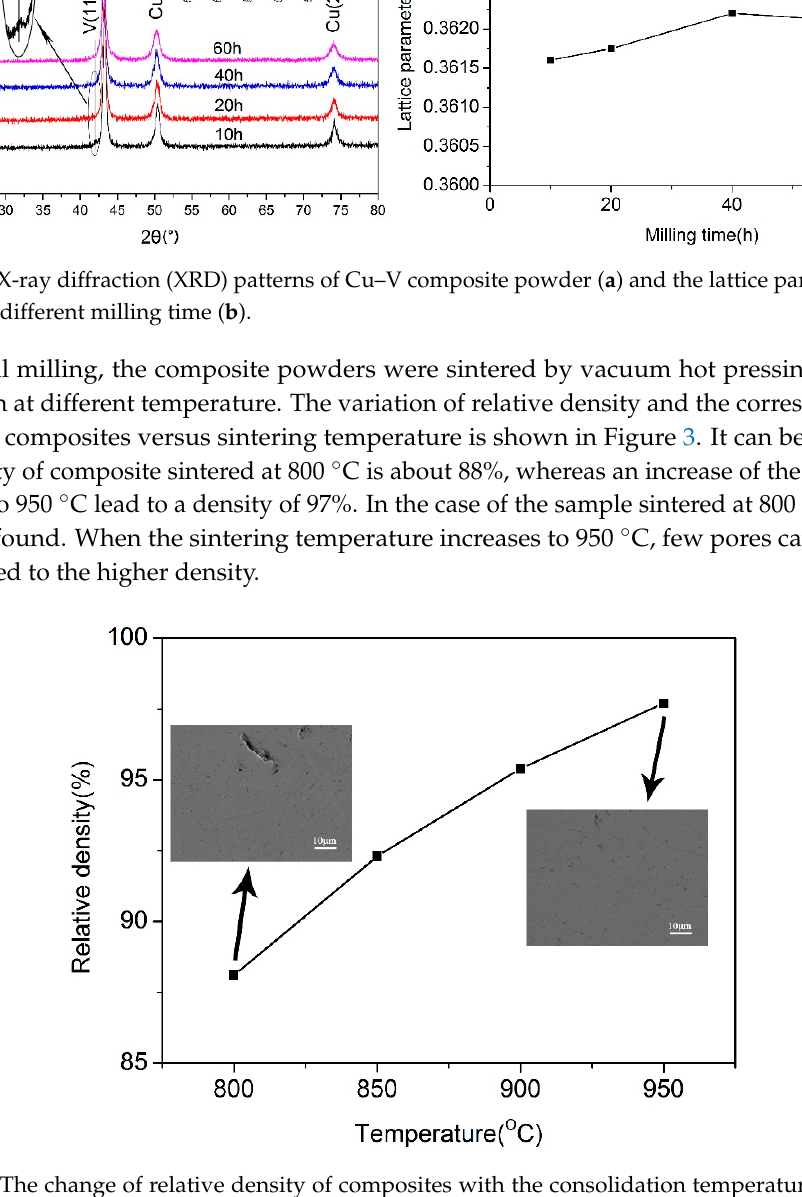
Figure 3. The change of relative density of composites with the consolidation temperatures. In the inset, SEM images show the microstructure of the composite sintered at 800 °C (left) and 950 °C (right).